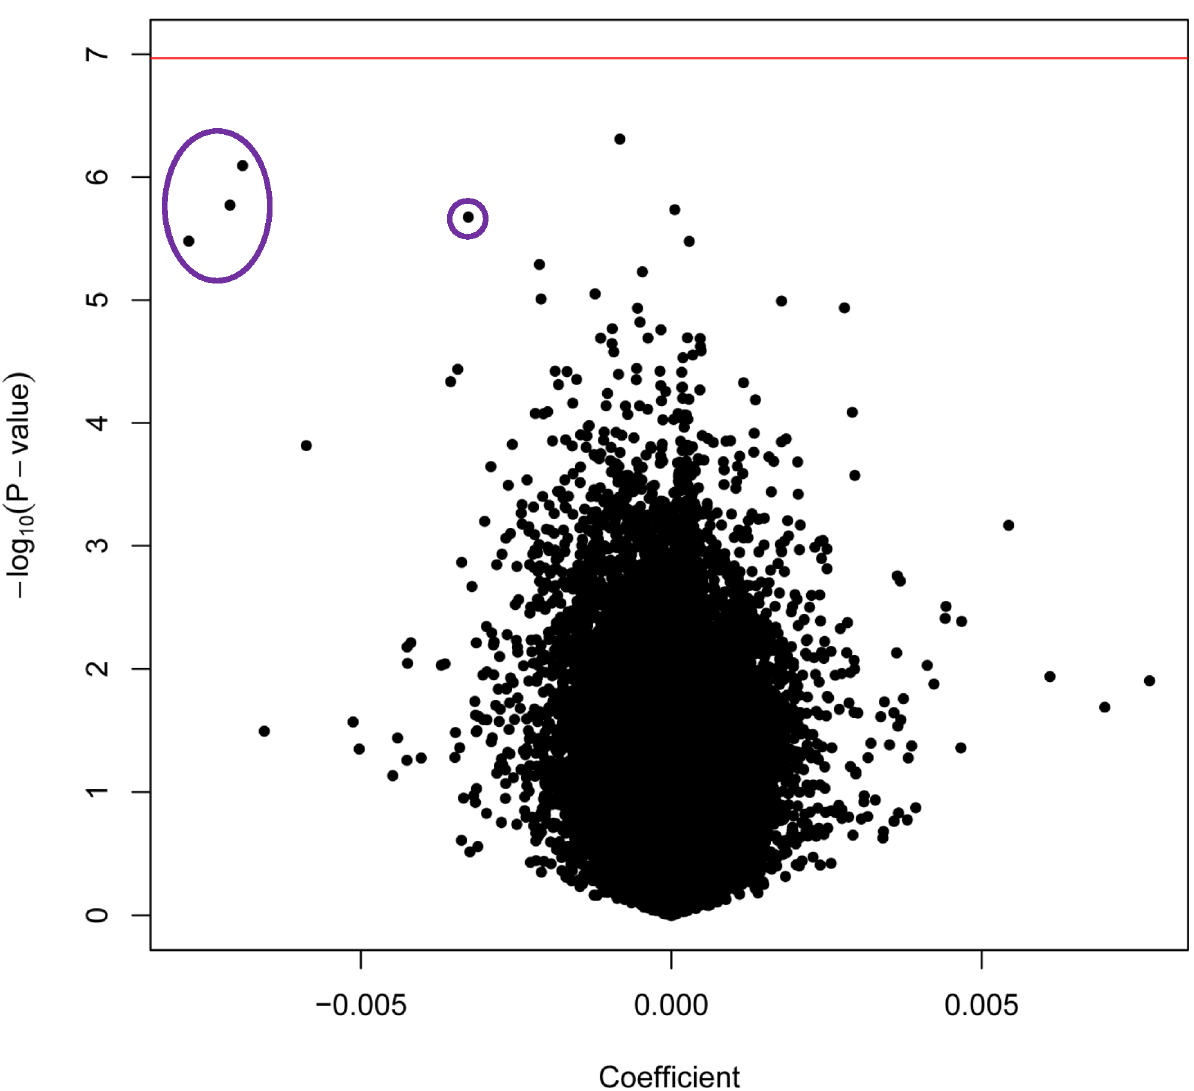
Fig 1. Epigenome-wide association results of maternal age in NFCS newborns. Volcano plot showing the relationship between the effect magnitude (coefficient) and strength of association (p-value) for Model1. The red horizontal line denotes the strict threshold for epigenome-wide significance based on a conservative Bonferroni correction for 465525 tests (p < 1.07x10 -7 ). The four CpGs that are circled in purple are near the second exon of the gene, KLHL35